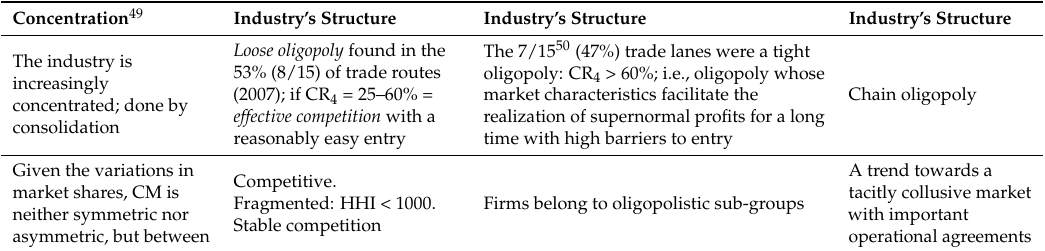
Table 1. Sys (2009) conclusions on containerized industry,